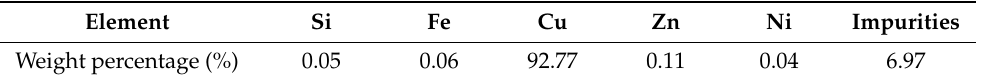
Table 1. Copper deposit XRF obtained by electrowinning of supercritical leachate.